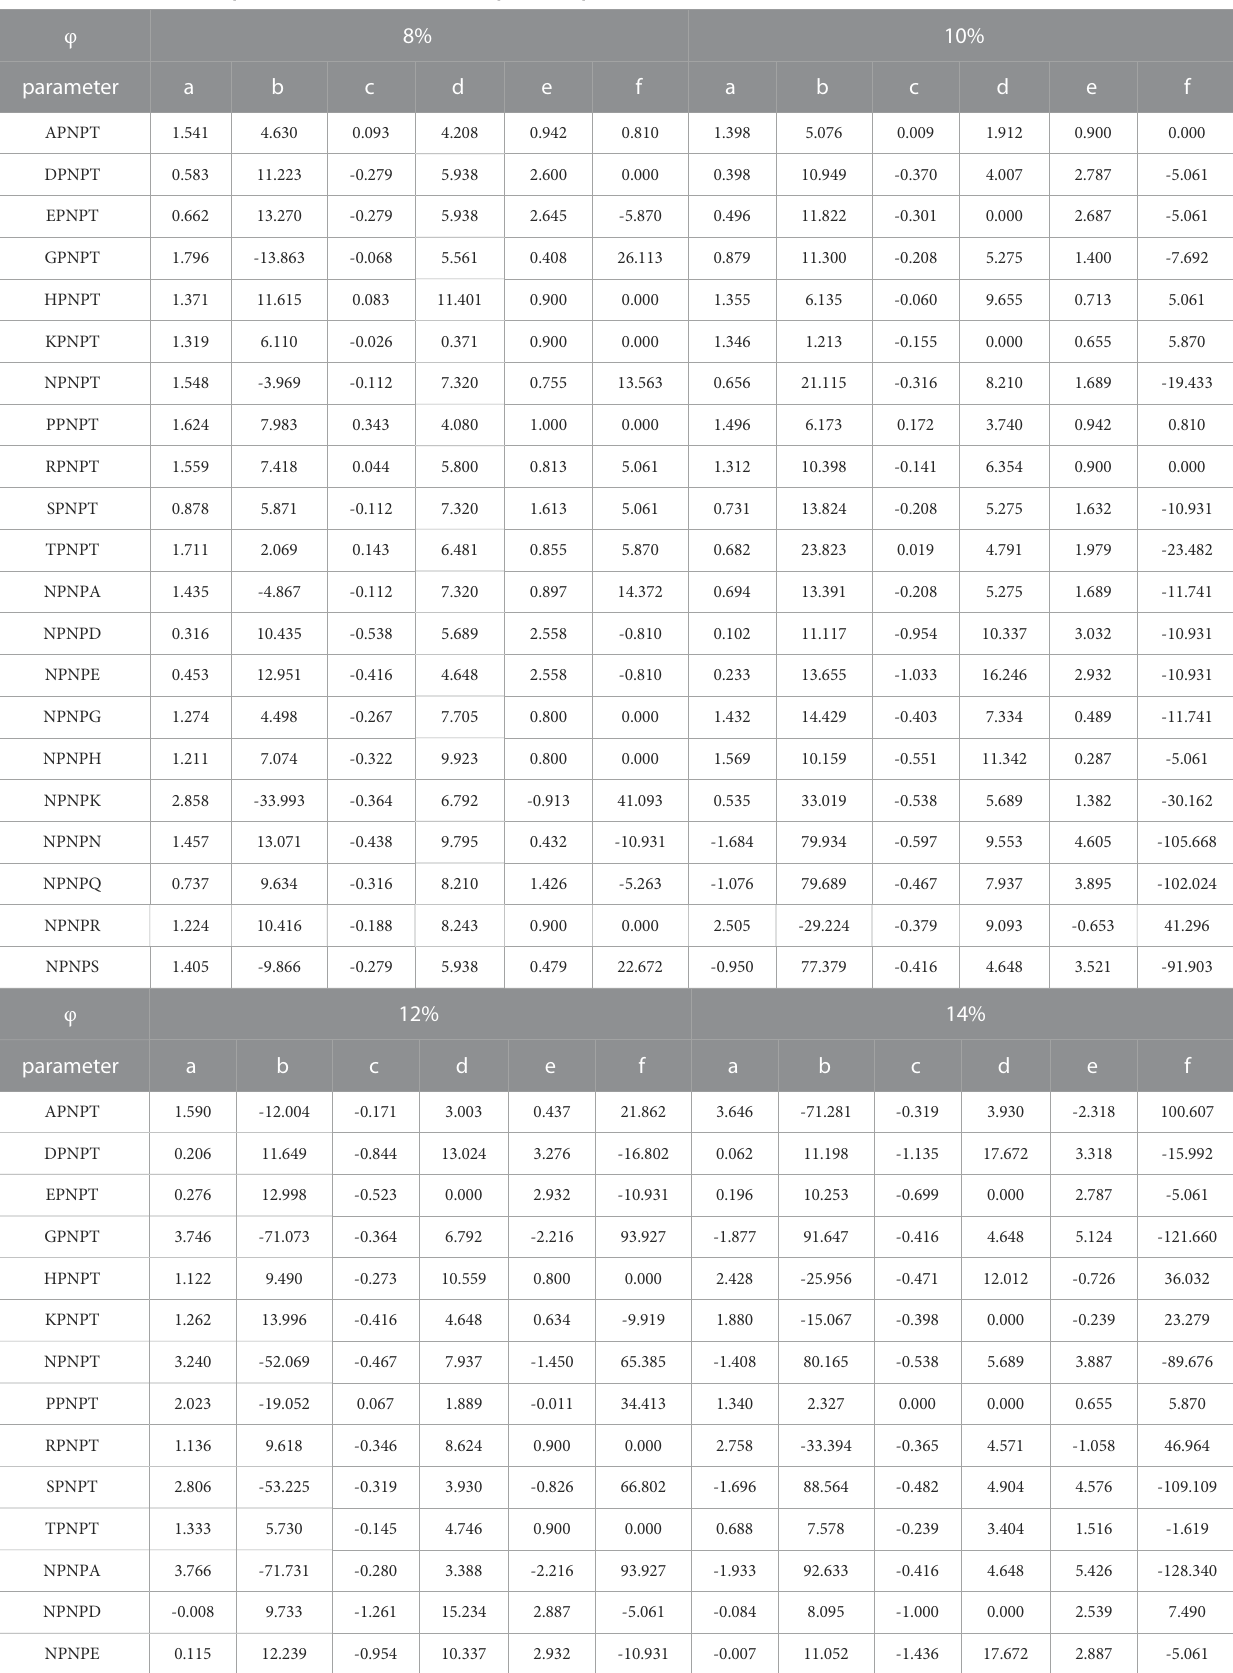
TABLE 5 Parameter results of pH and T under different mobile phase compositions. φ 8%